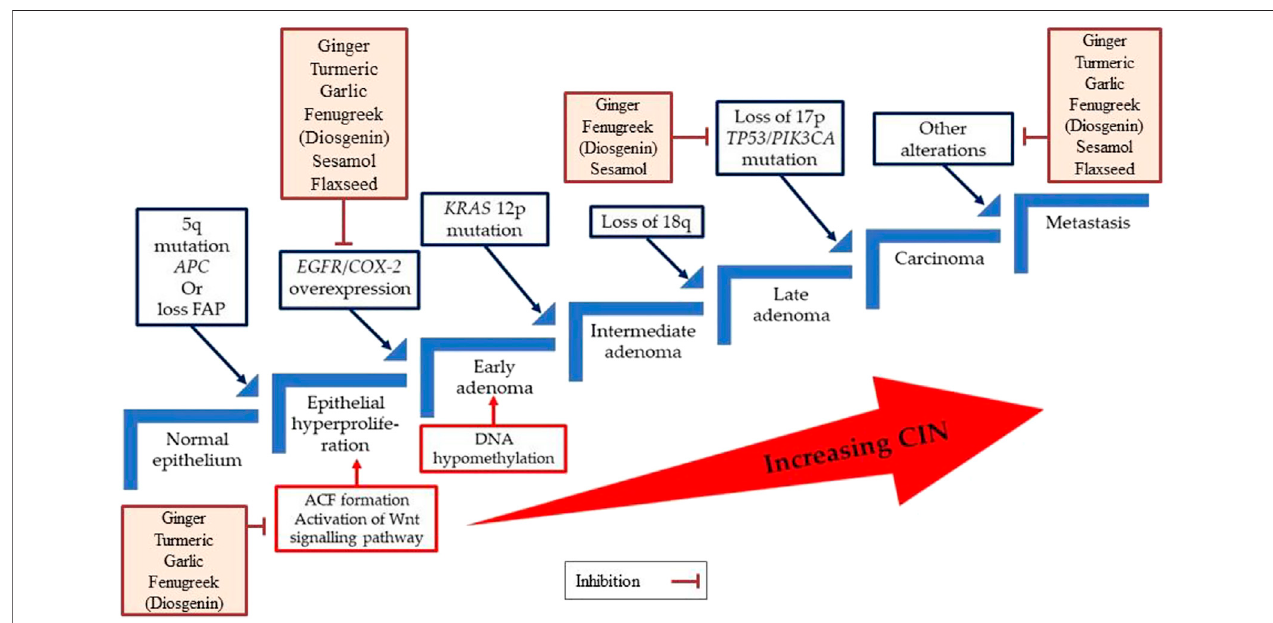
FIGURE 2 | A multistep genetic model of colorectal carcinogenesis sequence. ACF, Aberrant crypt foci; APC, Adenomatous polyposis coli, CIN, Chromosomal instability, COX-2, Cyclooxygenase-2; EGFR, Epidermal growth factor receptor; FAP, Familial adenomatous polyposis.